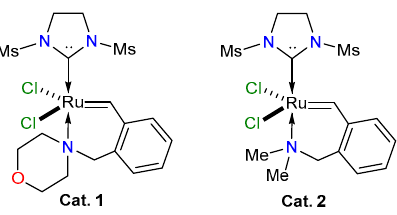
Figure 1. Hoveyda–Grubbs-type catalysts [27] used for metathesis reactions in the present work.